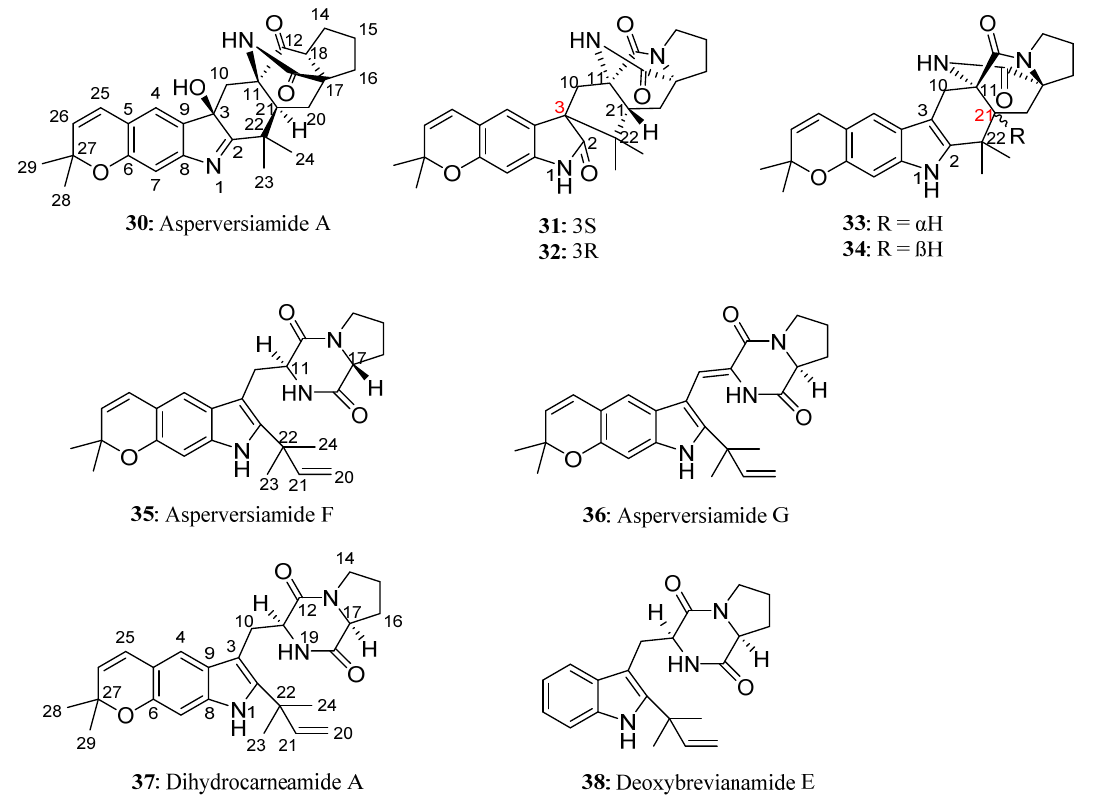
Figure 6. The structures of compounds 28a – 29b .